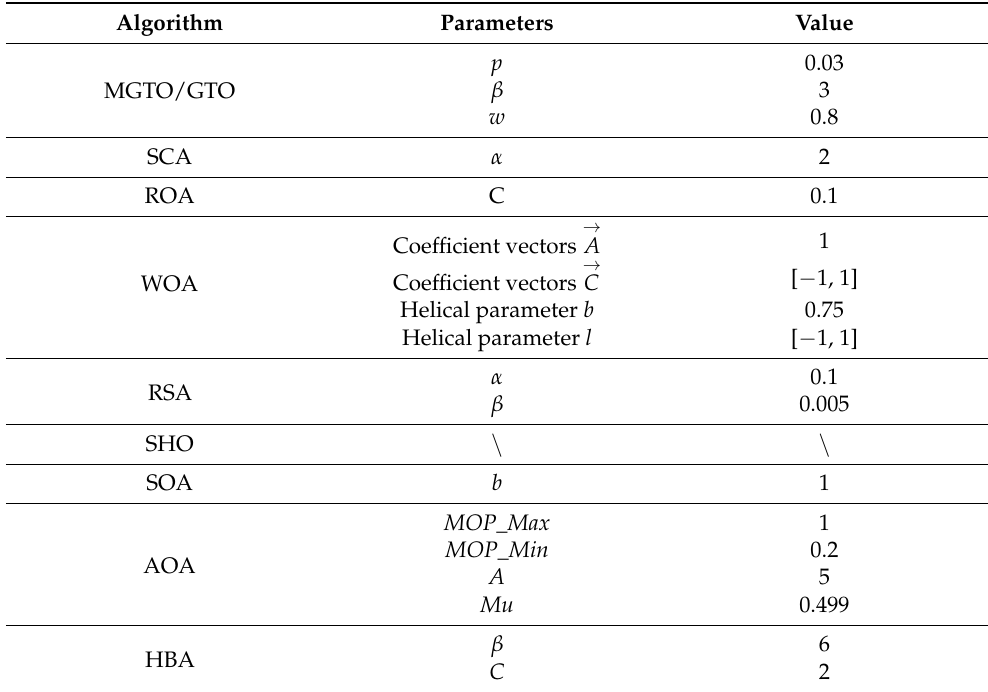
Table 1. Parameter settings for the comparative